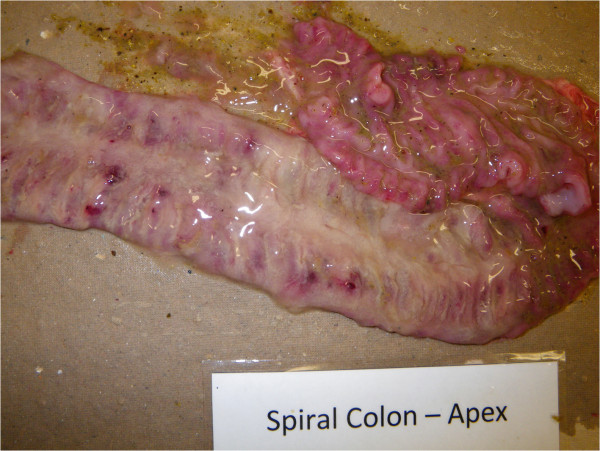
Mucohemorrhagic colitis. Congested mucosal surface of apex region of the spiral colon with thick layer of mucus and fibrin and occasional foci of haemorrhage. Pig #29, 12 days post inoculation, 48 hours post onset of mucohemorrhagic diarrhea.